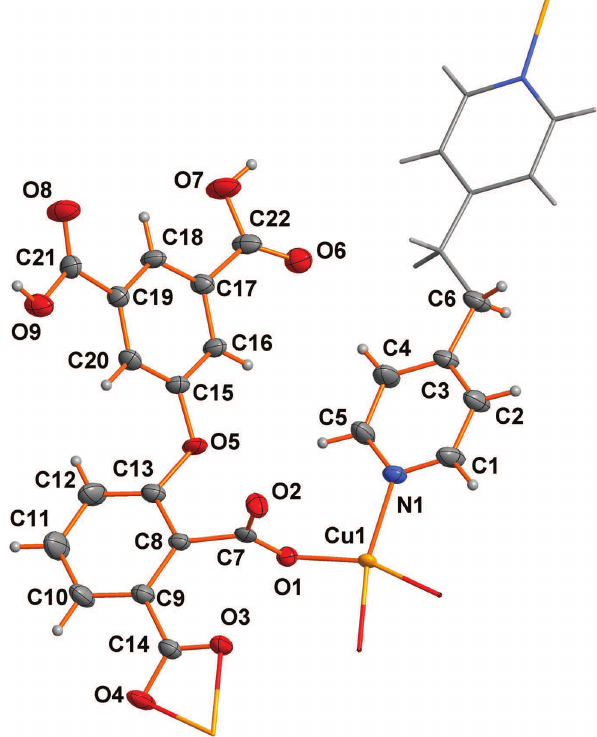
Table 1: Data collection and